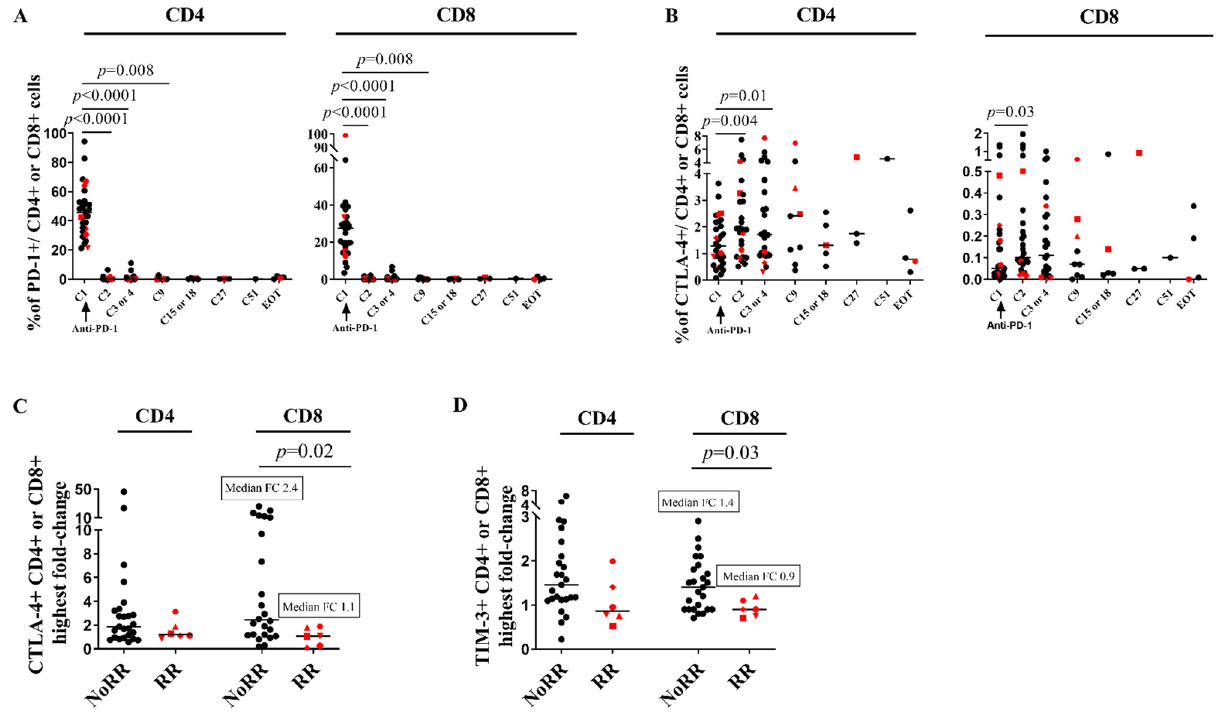
Figure 3. Anti-PD-1 therapy in PLWH with cancer induces dramatic decrease of PD-1 detection and slight and transient CTLA-4 expression increase. ( A ), Changes overtime in PD-1 expression on CD4 + (left) and CD8 + (right) T cells. ( B ), Changes overtime in CTLA-4 expression on CD4 + (left) and CD8 + (right) T cells. Bonferroni corrected p -value: p ≤ 0.007, Wilcoxon-matched pairs signed Rank test. Highest fold change at cycle 2 or 3 of ( C ), CTLA-4 + CD4 + (left) and CD8 + (right) T cells, and of ( D ), TIM-3 + CD4 + T (left) and CD8 + (right) among the patients without reservoir reduction (NoRR) and with reservoir reduction (RR). Mann–Whitney test. In each graph, red spots denote the patients RR. EOT: end of treatment. FC: fold change. At cycle 1, n = 32; at cycle 2, n =29; at cycle 3 or 4, n = 29; at cycle 9, n = 11; at cycle 15, n =5; at cycle 27, n = 3; at cycle 51, n = 1; at end of treatment, n = 5. Experiments were monoplicates.